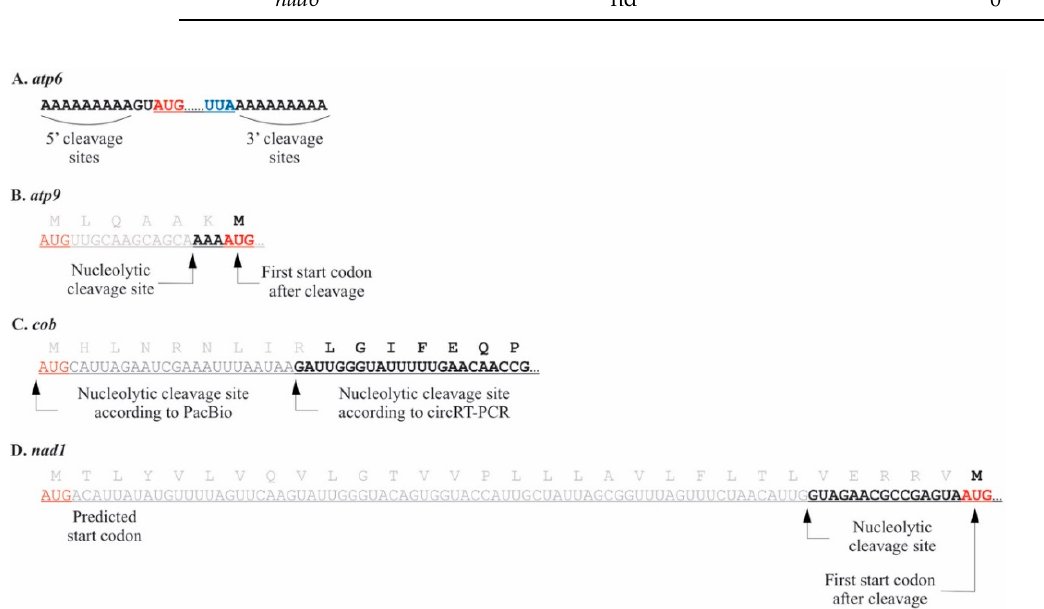
Figure 1. The 5 ′ termini and UTRs of four P. duplex mitochondrial mRNAs. Start codons are red, stop codons blue, and truncated portions of coding regions grey. ( A ). The 5 ′ UTR of the atp6 mRNA occurred within a 9 nt templated stretch of adenines that also appears downstream of the stop codon. ( B ). The atp9 5 ′ terminus occurred downstream of the AUG start codon in archived P. duplex chondriomes, suggesting the protein may be six amino acids shorter than predicted. ( C ). Two cob 5 ′ termini were detected. Circular RT-PCR revealed one downstream of the AUG start codon in archived P. duplex chondriomes, while the PacBio Iso-Seq technique revealed a terminus directly adjacent to the predicted start codon. ( D ). The nad1 5 ′ terminus occurred downstream of the AUG start codon in archived P. duplex chondriomes, suggesting the protein may be thirty amino acids shorter than predicted.